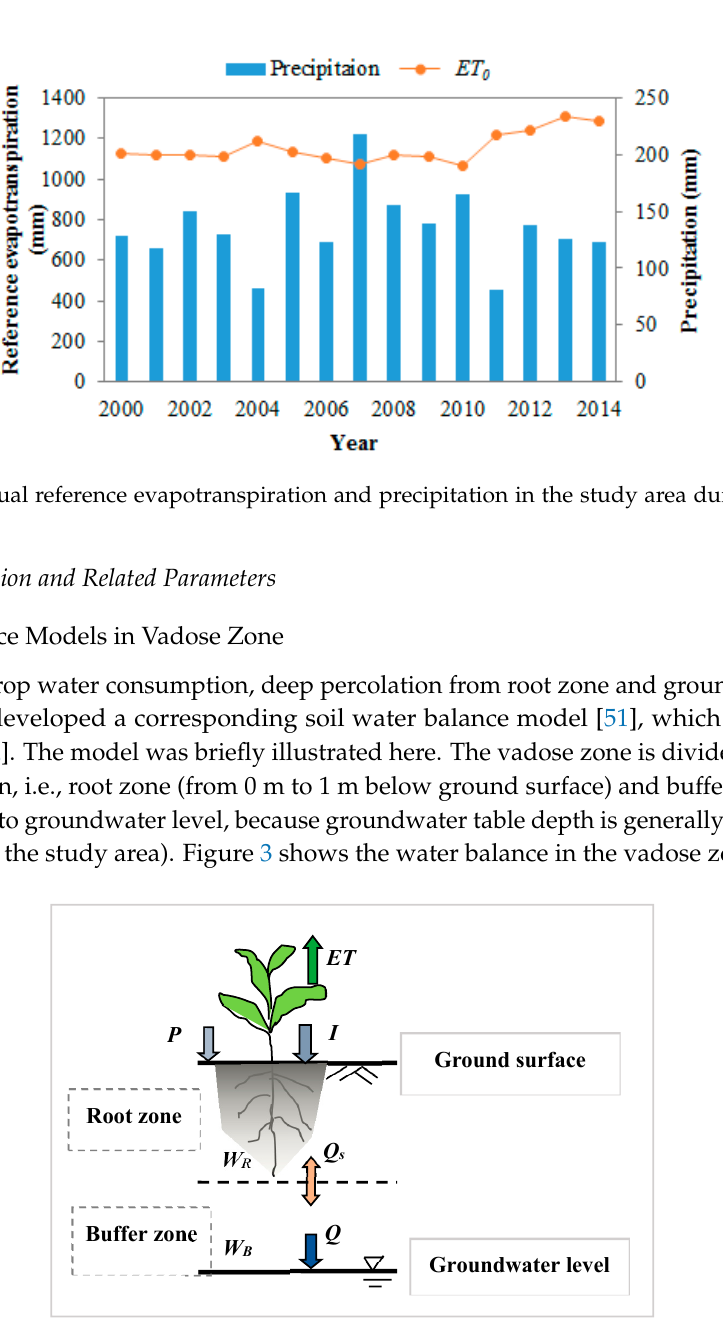
Figure 3. Water balance in vadose zone of farmland.